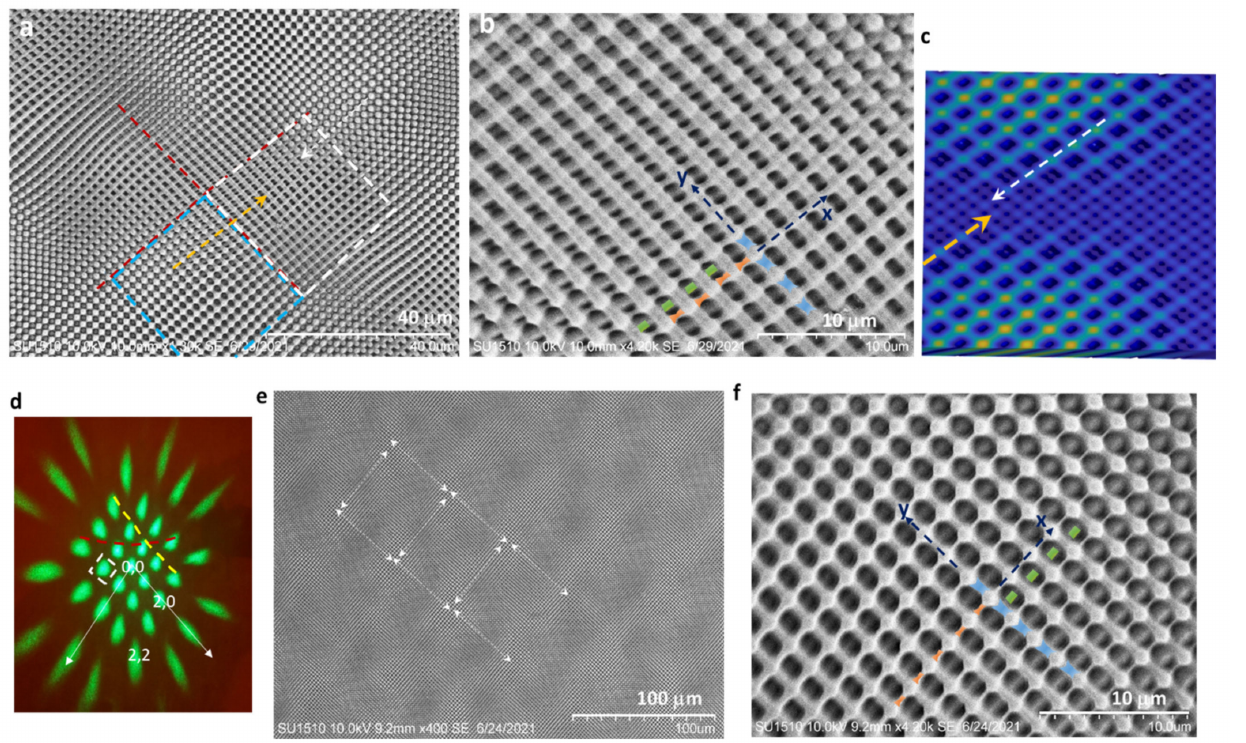
Figure 4. ( a ) SEM image of type-3 3D GPSC. The dashed white and blue squares indicate sub-units with more woodpile-like structures and dot-like structures, respectively. The size of the dots decreases along the dashed yellow and white lines. ( b ) An enlarged view of SEM image of type-3 3D GPSC. ( c ) Simulation of GPSC shows a decrease in dot sizes along the dashed yellow and white lines. ( d ) 5 × 5 Diffraction zones from type-3 3D GPSC showing the diffraction orders. ( e ) SEM image of type-3 3D GPSC shows the same diffraction zones. ( f ) Enlarged view of SEM image showing the layer-by-layer structure as indicated by dashed orange, blue, and green lines.